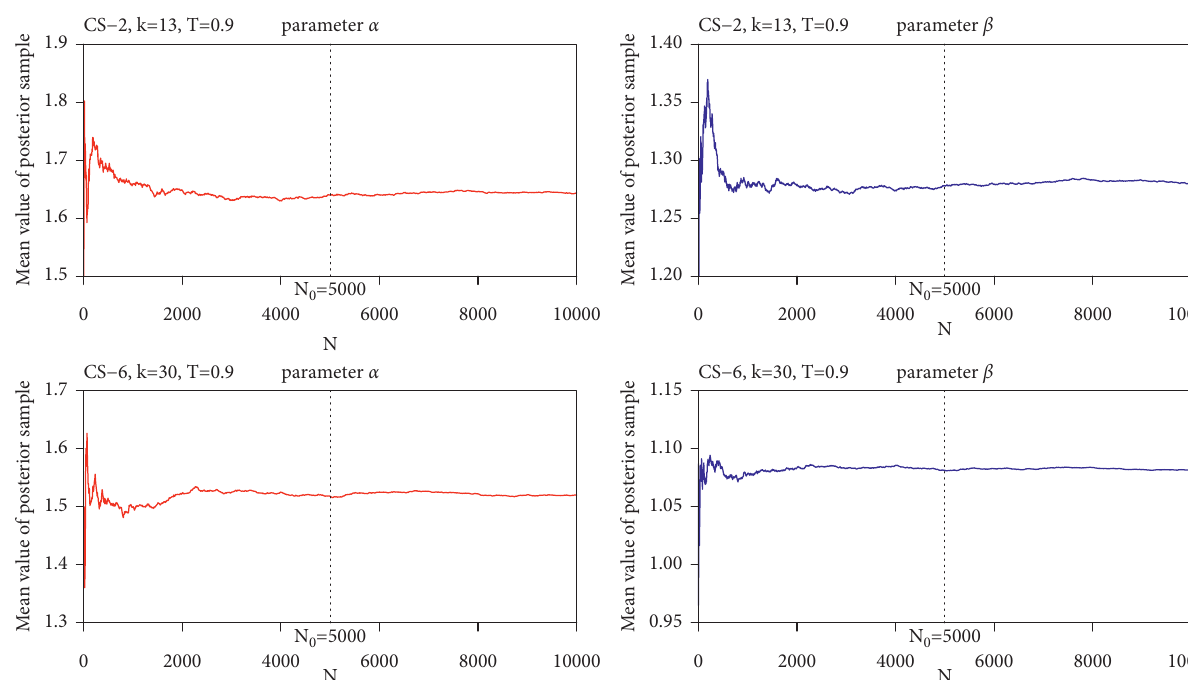
Figure 3: The sampling iterative trend plots of parameter ( α , β ) � ( 1 . 5 , 1 ) under different censoring